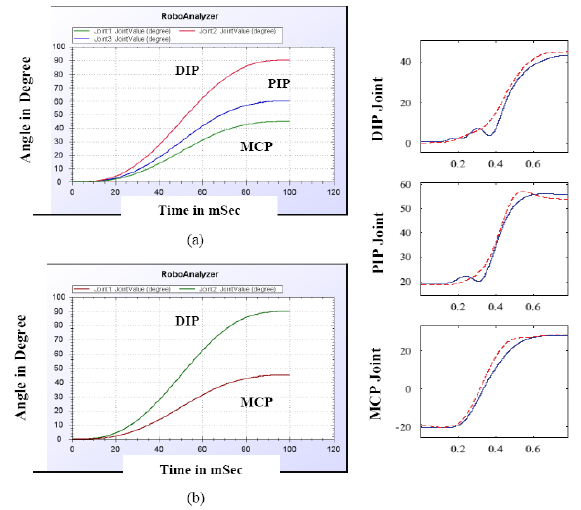
Figure 9. Joint Trajectories of (a) Prosthetic Hand Index Fingers: Joint1 = MCP Joint, Joint2 = PIP Joint, Joint3 = DIP Joint. (b) Prosthetic Hand Thumb: Joint1 = MCP Joint and Joint2 = DIP Joint. (c) Human Hand Index Finger (Figure ’c’ adapted from [22]).